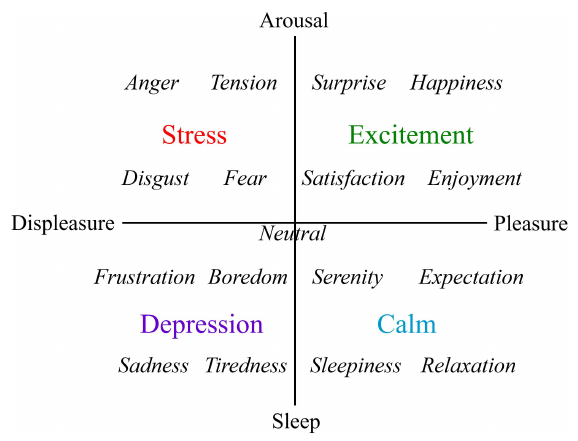
Figure 3. Modified PA plane with four emotional